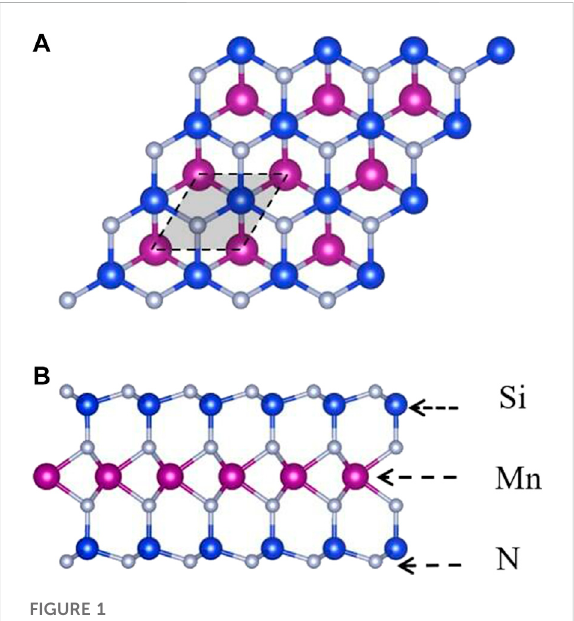
FIGURE 1 Top (A) and side (B) views of MnSi 2 N 4 . The balls are highlighted with blue (Si atom), purple (Mn atom) and silvery (N atom). The rhombic unit cells are marked with black dashed